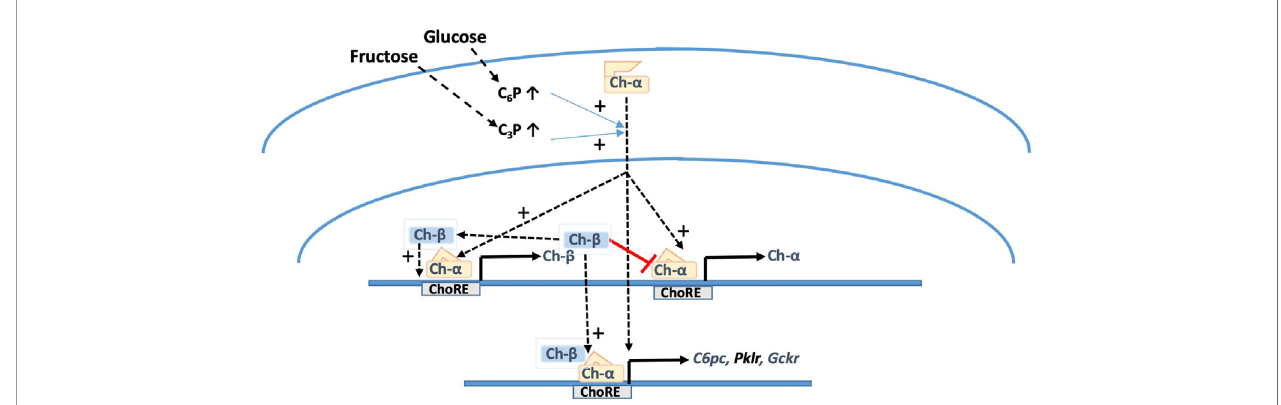
FIGURE 1 | Metabolite-mediated activation of ChREBP- a and induction of ChREBP- b . Substrates that raise cellular levels of hexose-phosphates (C 6 P) and triose- phosphates (C 3 P) cause translocation of full-length ChREBP- a from the cytoplasm to the nucleus and binding to upstream (ChREBP- b ) and downstream (ChREBP- a ) ChoREs of the ChREBP gene and to ChoREs of various ChREBP target genes G6pc , Pklr , and Gckr . ChREBP- b which unlike ChREBP- a is present constitutively in the nucleus exerts positive feedback on its own promoter but negative feedback on the downstream ChREBP- a promoter. This accounts for the modest changes in ChREBP- a mRNA levels in comparison with ChREBP- b mRNA during high glucose